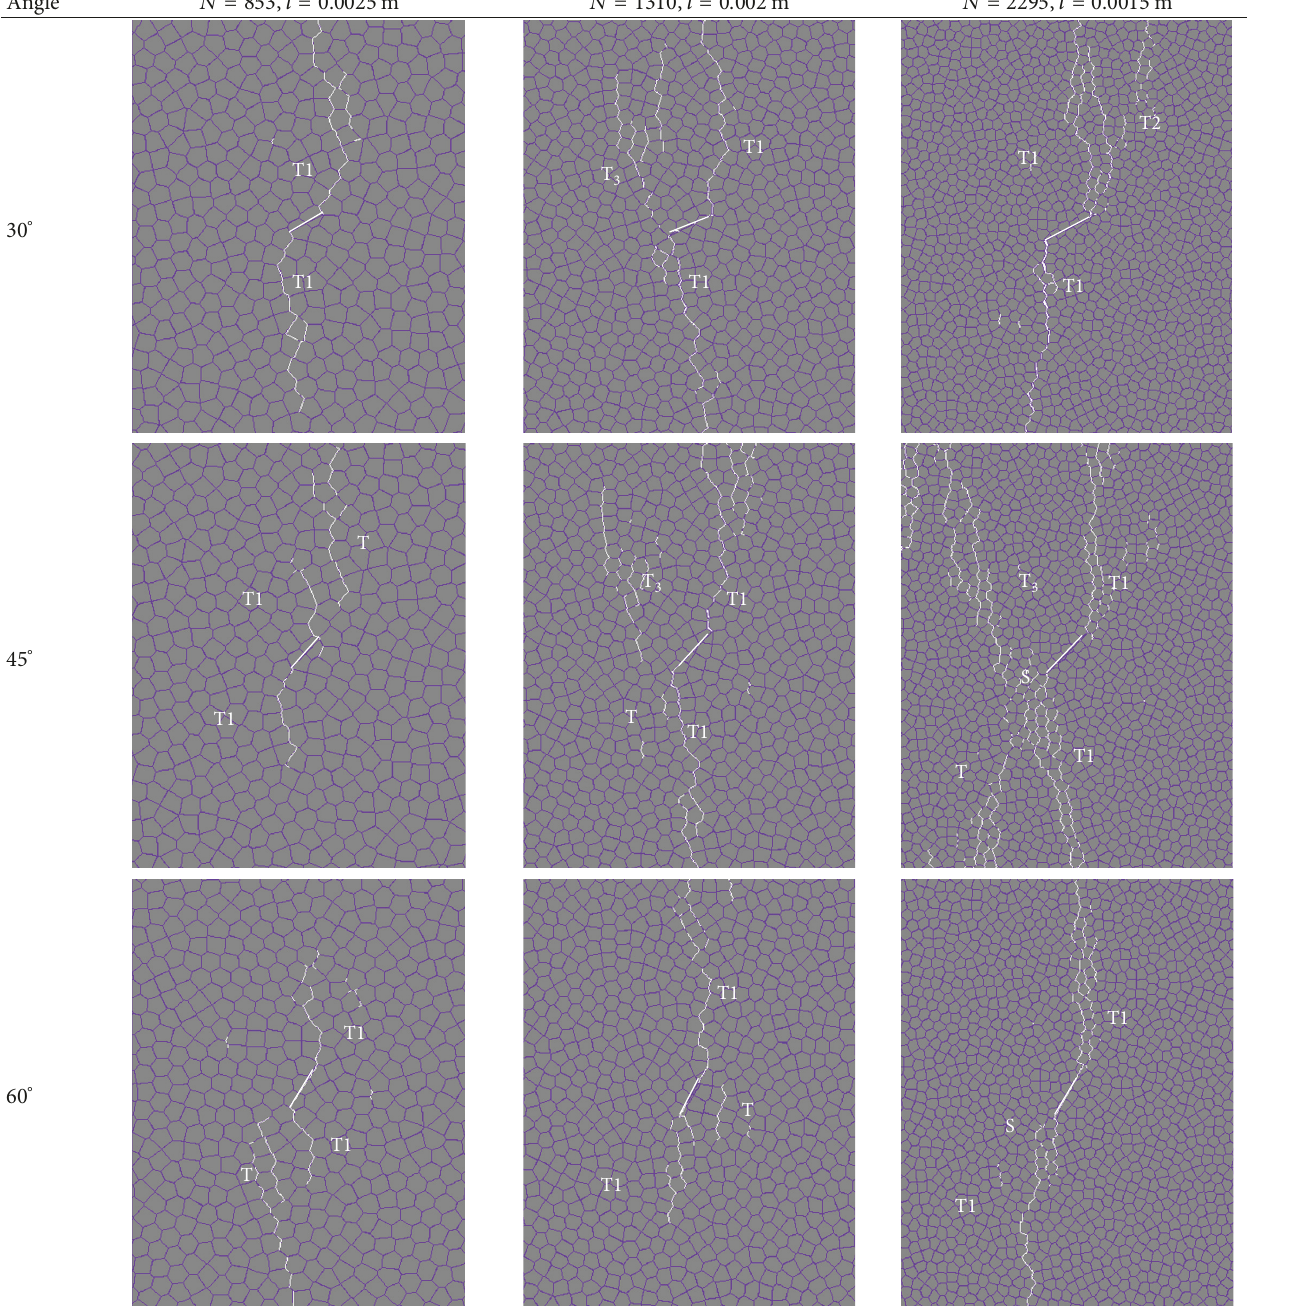
Table 6: The crack process with length of 1 mm and flaw angle 𝛽 of 30 ∘ , 45 ∘ , and 60 ∘ under different grain sizes ( 𝑙 : average length, 𝑁 : the number of grains, T1: tensile wing crack, S: shear crack, T: tensile crack, T2: type 2 tensile crack, and T3: type 3 tensile crack). Angle 𝑁 = 853 , 𝑙 = 0.0025